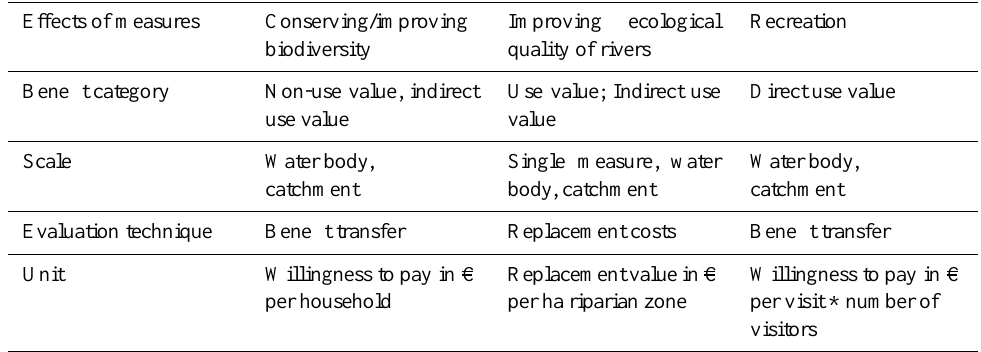
Table 1. Categories and scales of the ecological benefit criterion (changed from Dietrich and Schumann, 2006). Effects of